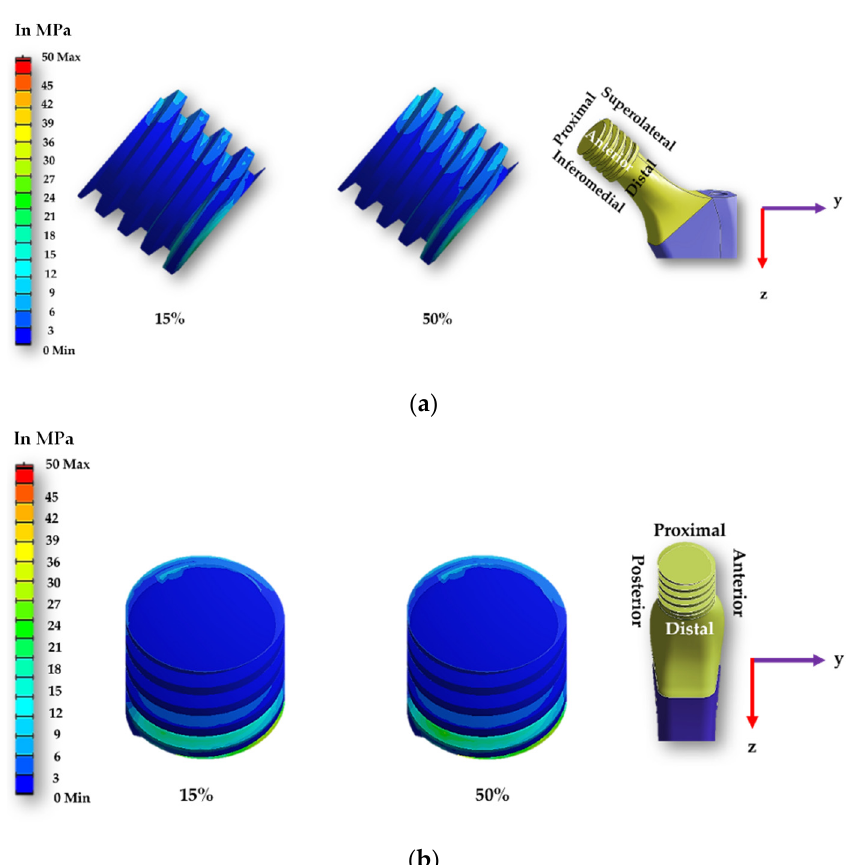
Figure 10. Contact pressure distribution over a spiral head-neck tapered joint from the ( a ) front and ( b ) right side for 15% and 50% of walking loading condition gait cycle.